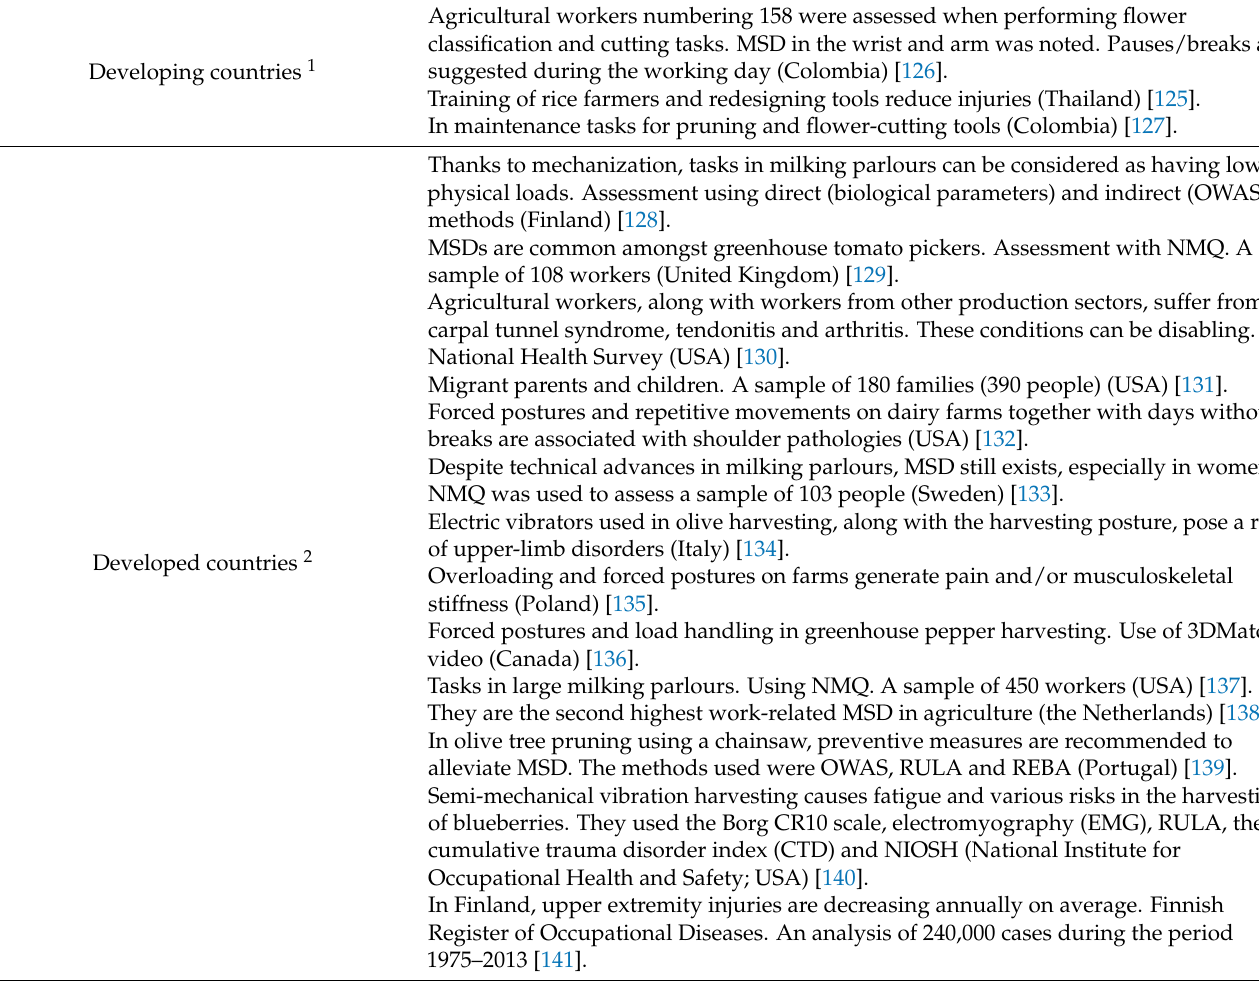
Developing countries 1